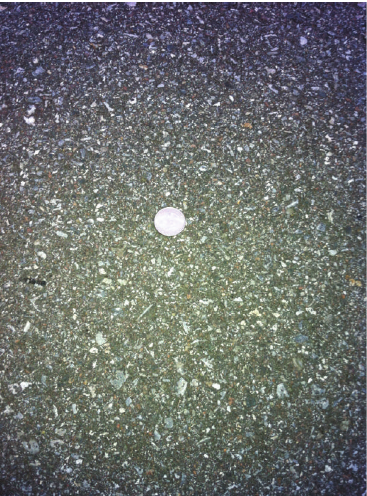
Figure 11: Close-up of the Belcher Road asphalt pavement depicting the lack of polishing and presence of